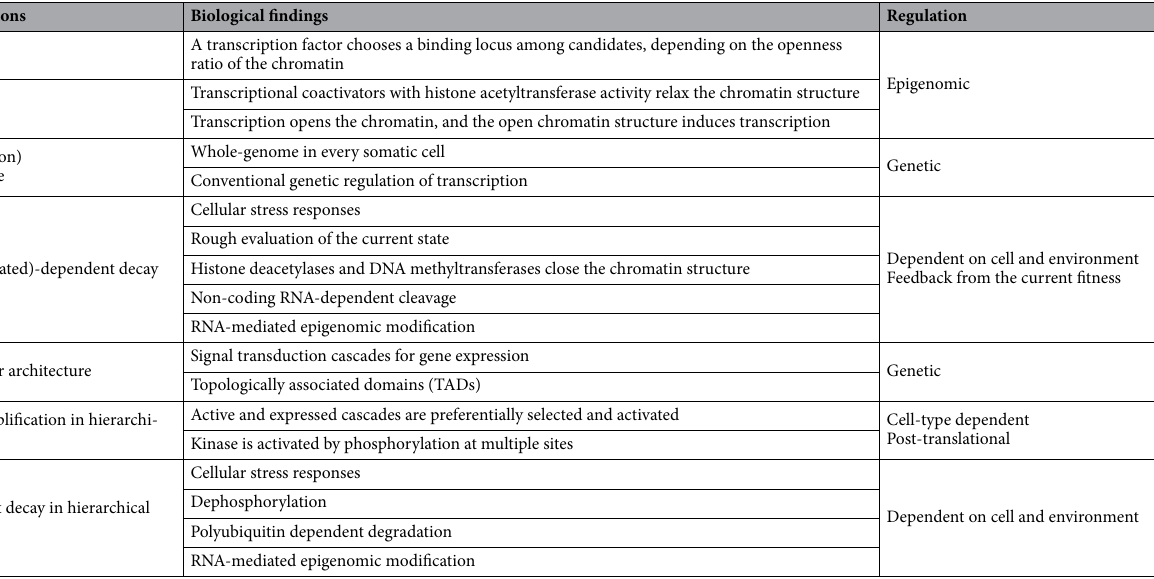
Table 2. Assumptions in the learning hierarchical-pair model are supported by biological knowledge. Epigenetic regulations, which are highly variable depending on cell type, can be interpreted as a process of competitive amplification. The decay rate is roughly regulated at several levels by the fitness of the current expression pattern in each pair. The correct expression level of each gene is not supervised in real cells. Instead, two functionally related gene-groups are regulated in a pair, in which the inappropriate expression ratio induces cellular stress, increases the decay, and destabilizes the ratio. As a possible feedback regulation for the error-dependent decay, cleaved mRNA fragments coding excessive proteins may close the genome loci. Hierarchical pairs are genetically determined and consistent in all